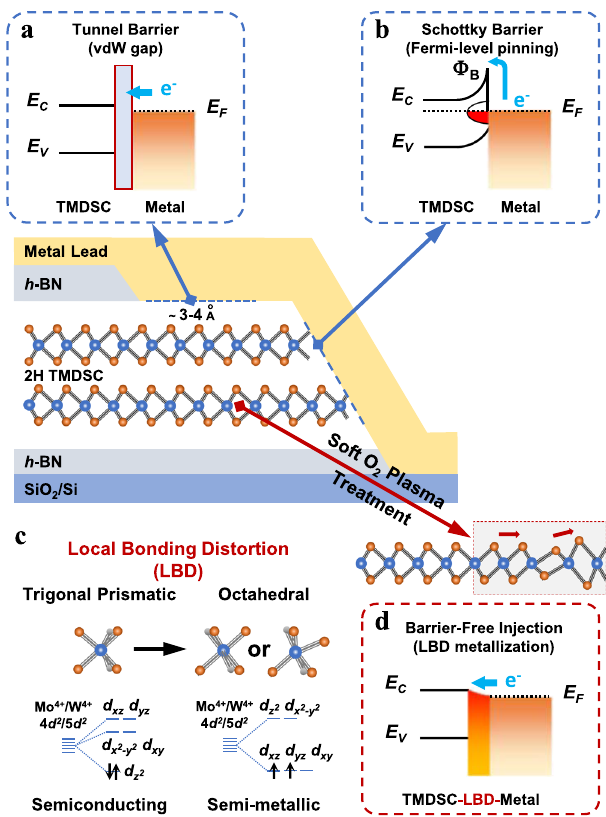
Fig. 1 Different electrical interfaces between atomically thin TMDSCs and metal leads. a Interfacial band alignment of the van der Waals (vdW) contact. b Interfacial band alignment of the Schottky-limited contact. c Atomic con fi gurations of [TM-C 6 ] polyhedra and corresponding energy splitting diagrams of Mo/W d-orbitals before and after the local bonding distortion (LBD). d Interfacial band alignment of the contact utilizing LBD mechanism. E C and E V represent the energy of conduction and valence band edges in TMDSCs, respectively. E F indicates the Fermi-level energy in metal leads while Φ B denotes the Schottky barrier height. Blue arrows suggest the routes for carrier injection, where e − indicates the electron